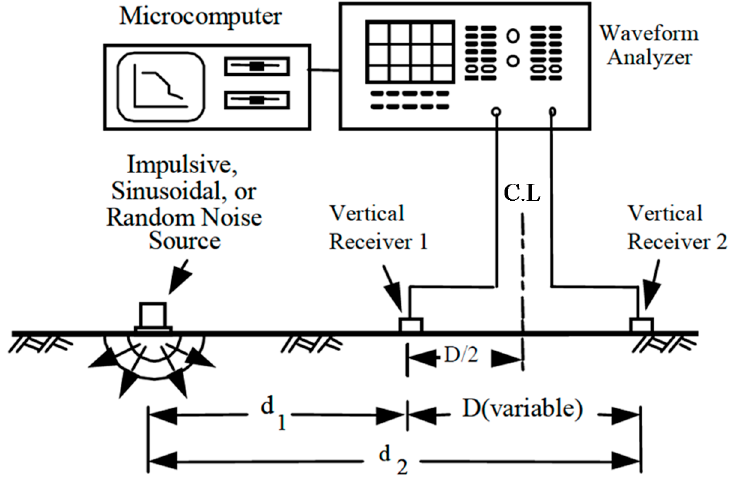
Figure 4. Schematic diagram of Spectral Analysis of Surface Waves Method (SASW) (Stokoe et al. [24]).